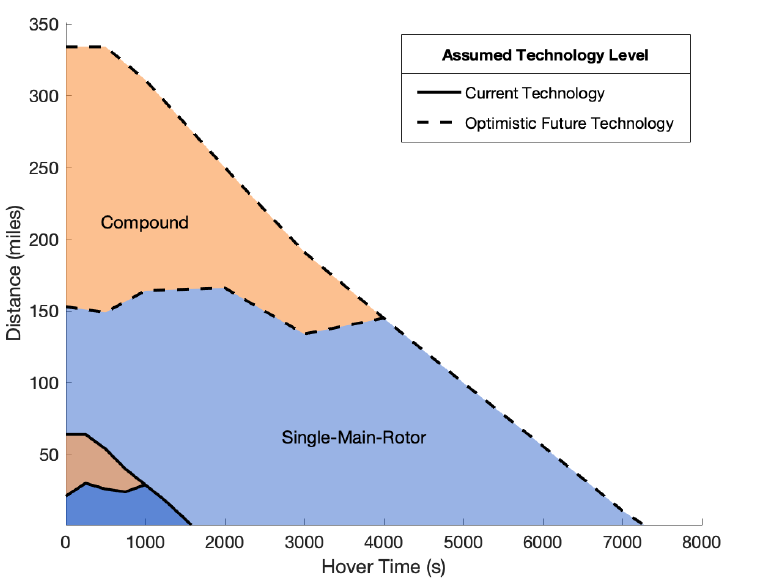
Figure 8. Feasible design space with most efficient options for a 2-passenger payload and 100 knot cruise speed assuming a decoupled drive-train.